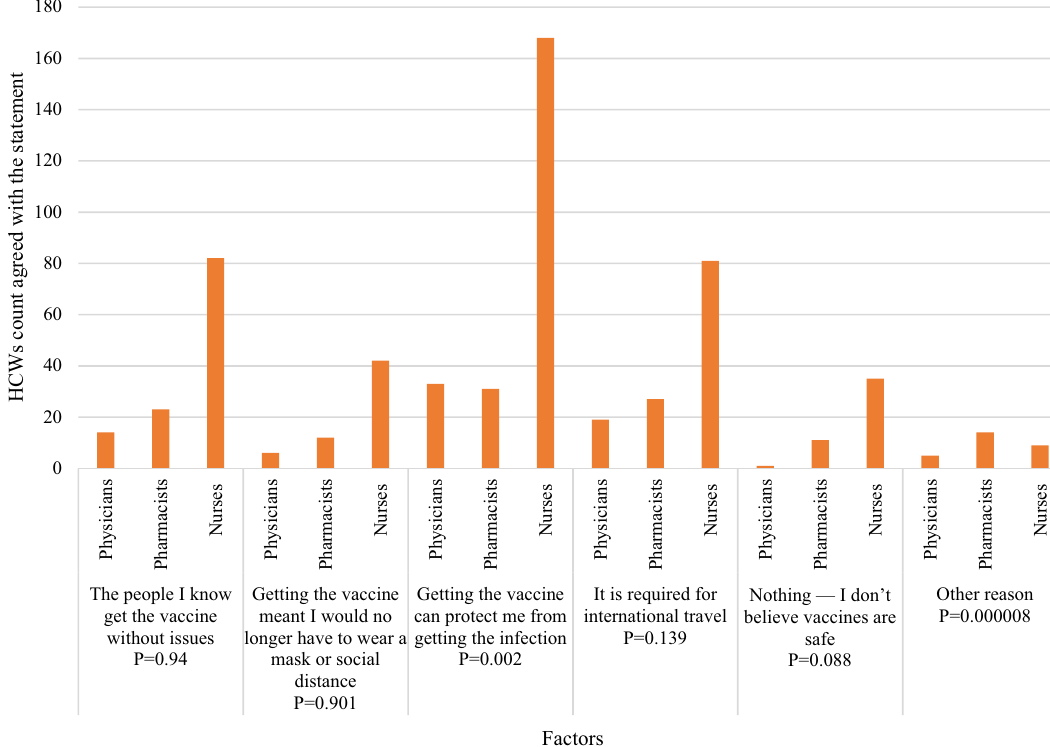
Figure 3. HCWs responses to “What might convince you to take a COVID-19 vaccine OR convinced you if you already took it? (Choose all that